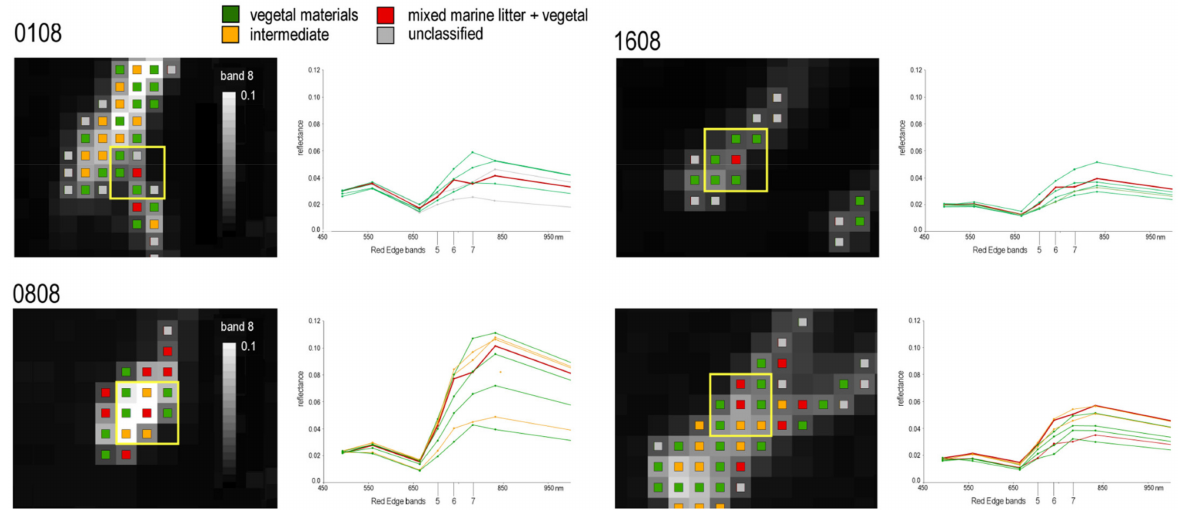
Figure 7. Examples of marine litter spectra (in red) surrounded by different pixels in actual patches detected in North Adriatic in August